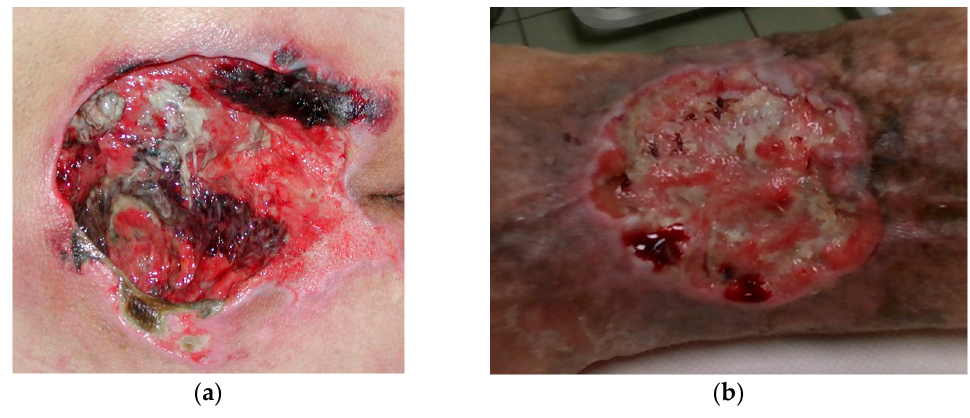
Figure 1. Wound located on: ( a ) lower back region; ( b ) leg region.